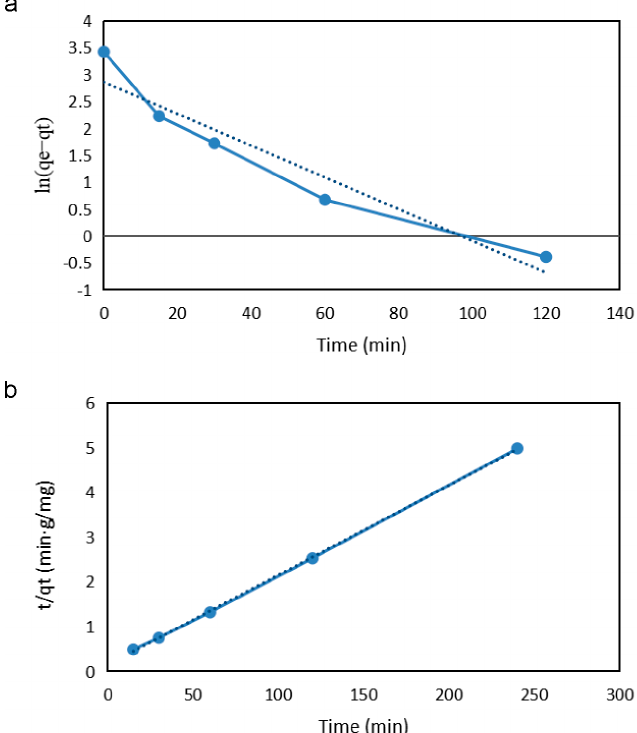
Figure 6. Static adsorption and dynamic adsorption results of activated carbon. ( a ) Static adsorption; ( b ) dynamic adsorption on the feed concentration of 2 ′ -FL with 10 g/L.